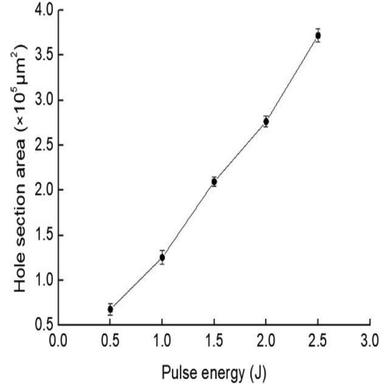
Influence of the laser pulse energy on the semi-circular section area for blind holes drilled using the first laser pulse.